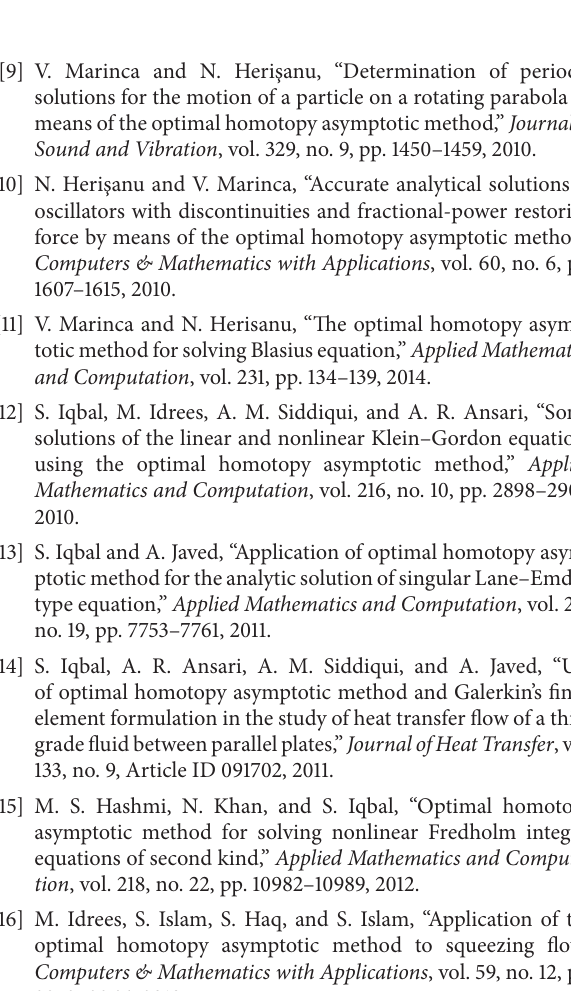
Figure 7: Error convergence with the order of approximation of 𝑢(𝑥,𝑦,𝑡) and V (𝑥, 𝑦,𝑡)